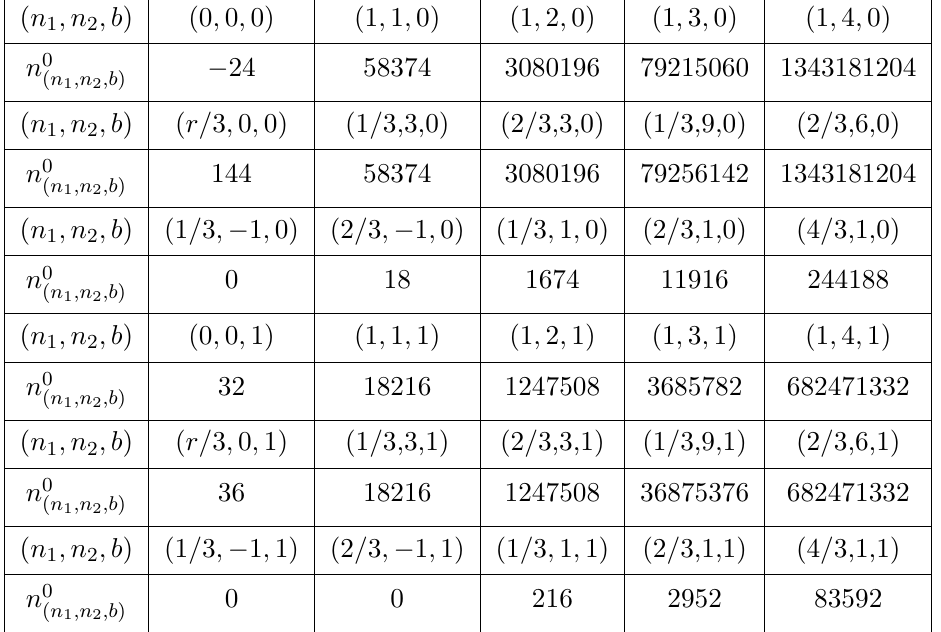
Table 14 . 3 A orbifold, non-standard embedding with single Wilson line. Shift is given by, (cid:13) =